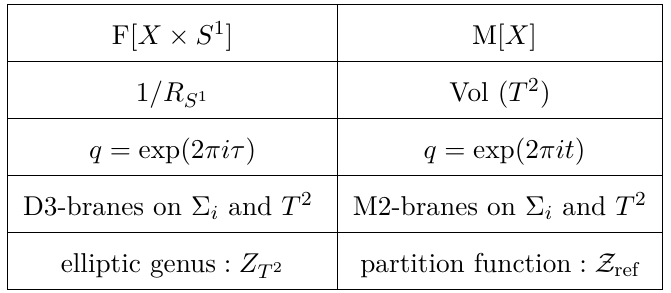
Table 1 . Duality between F-theory and